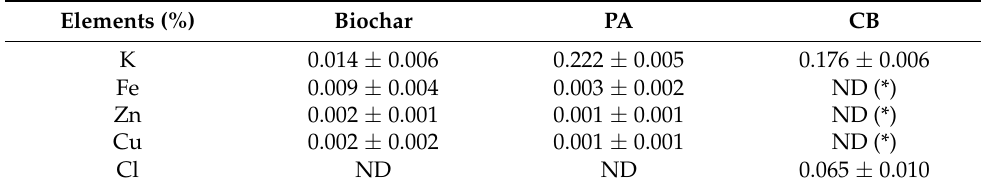
Table 4. EDX elemental analysis for the Biochar and immobilized biocatalysts.